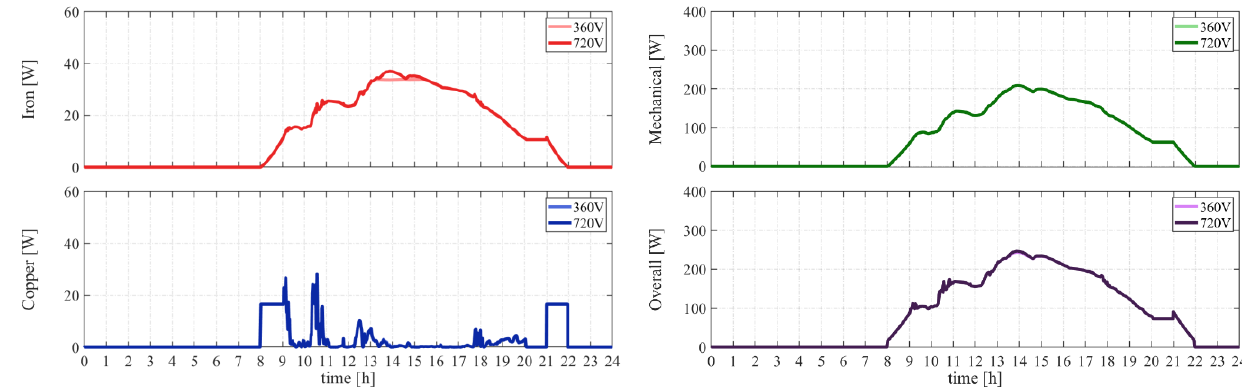
Figure 17. Losses evolutions achieved over a real operating scenario @360 V and @720 V (case C2).